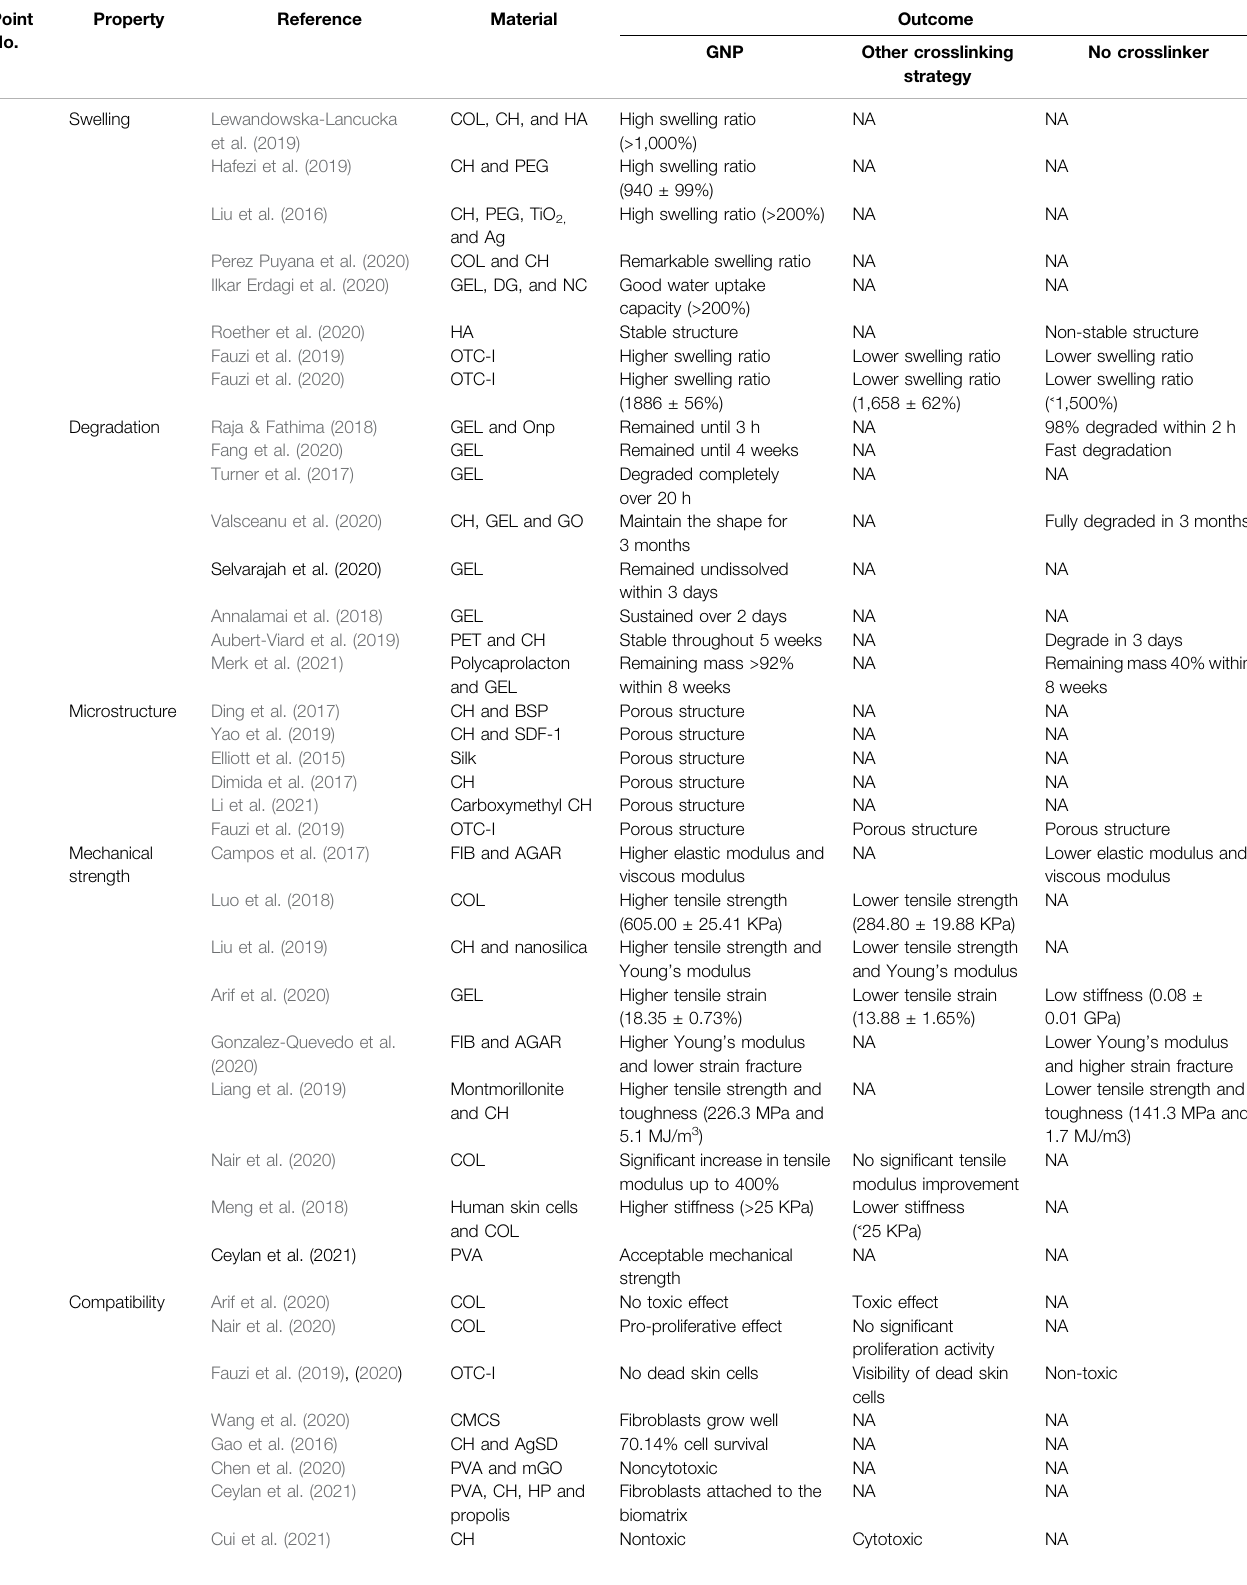
TABLE 2 | Comparison of properties between GNP-crosslinked with other crossslinkers — crosslinked and uncrosslinked groups. Point